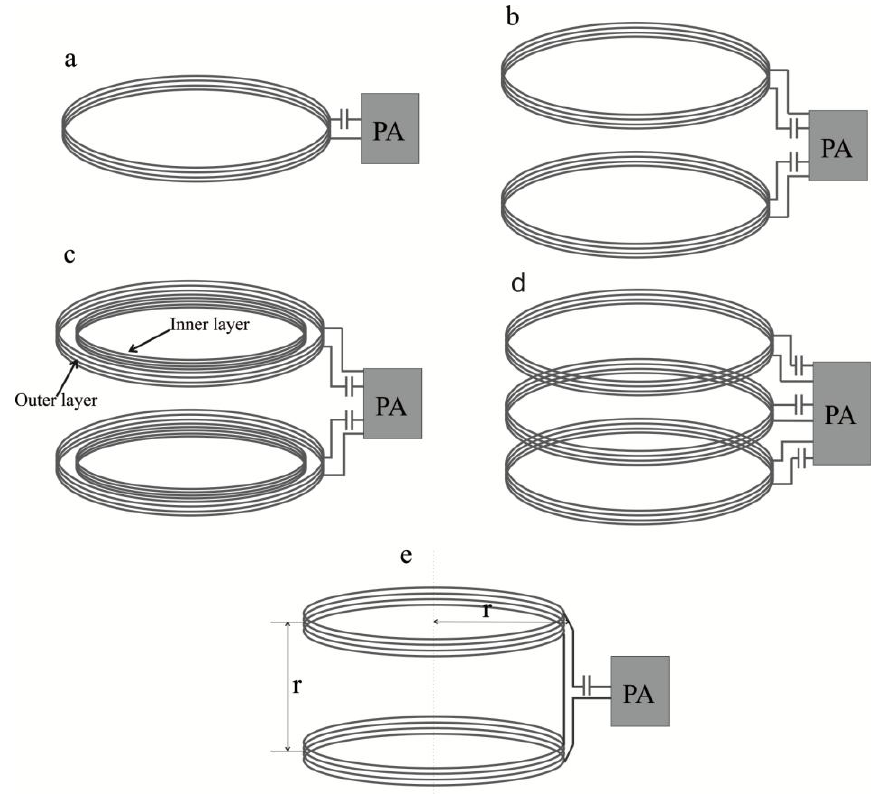
Figure 3. Common structures of TC: ( a ) solenoid; ( b ) pair of solenoid; ( c ) pair of double layer solenoid; ( d ) segmented solenoid; ( e ) Helmholtz coil. PA = power